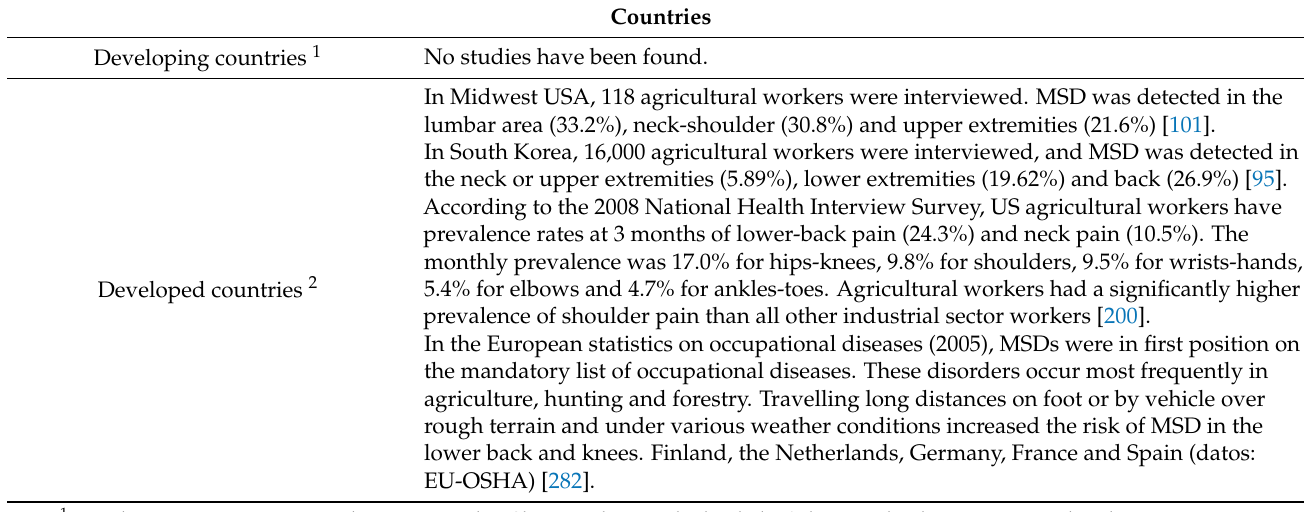
Table A16. MSD research in agriculture (1995–2020). Category: Countries.